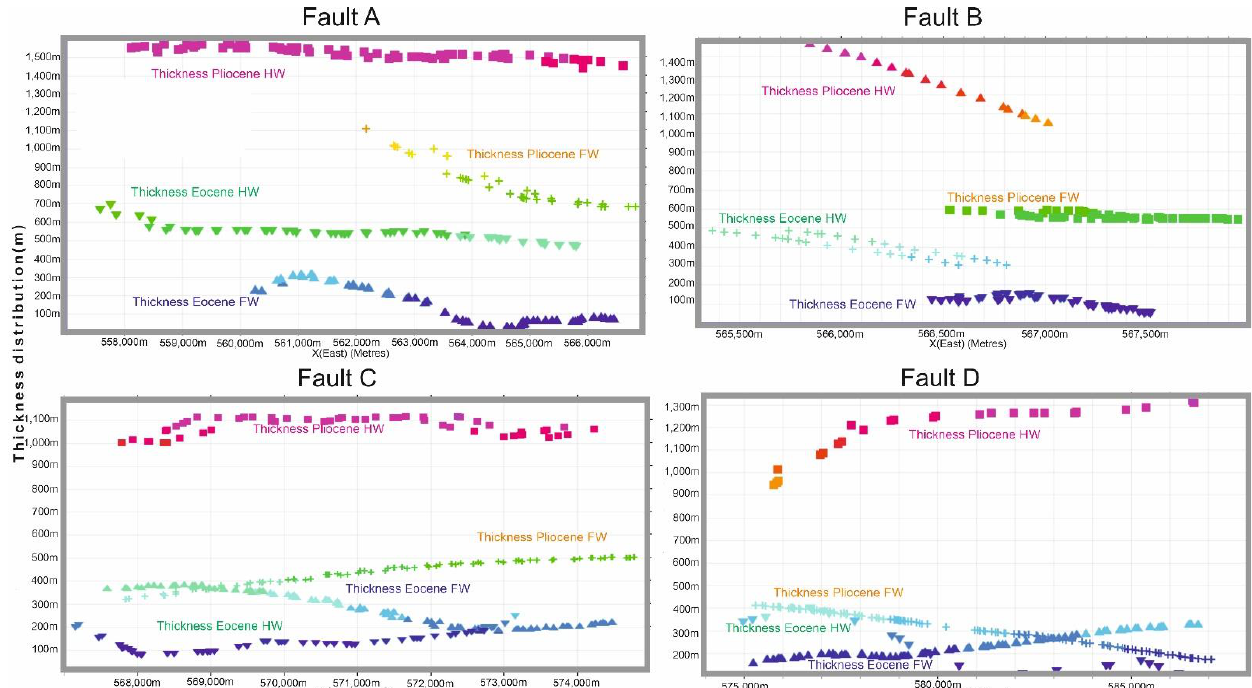
Figure 8. Thickness variations of Eocene and Pliocene stratigraphic units projected along sections oriented parallel to the strike of the A to D fault segments.